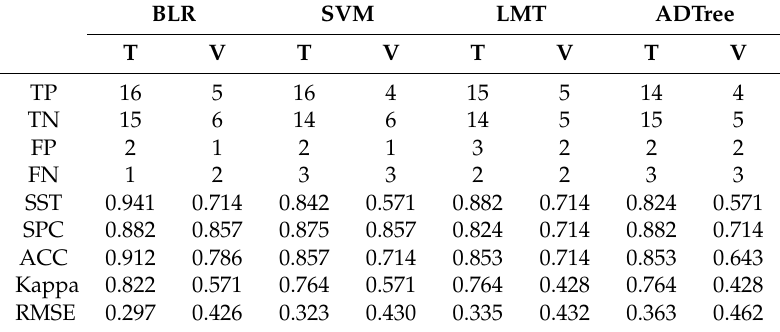
Table 2. Model results and analysis using training and validation datasets. TP: true